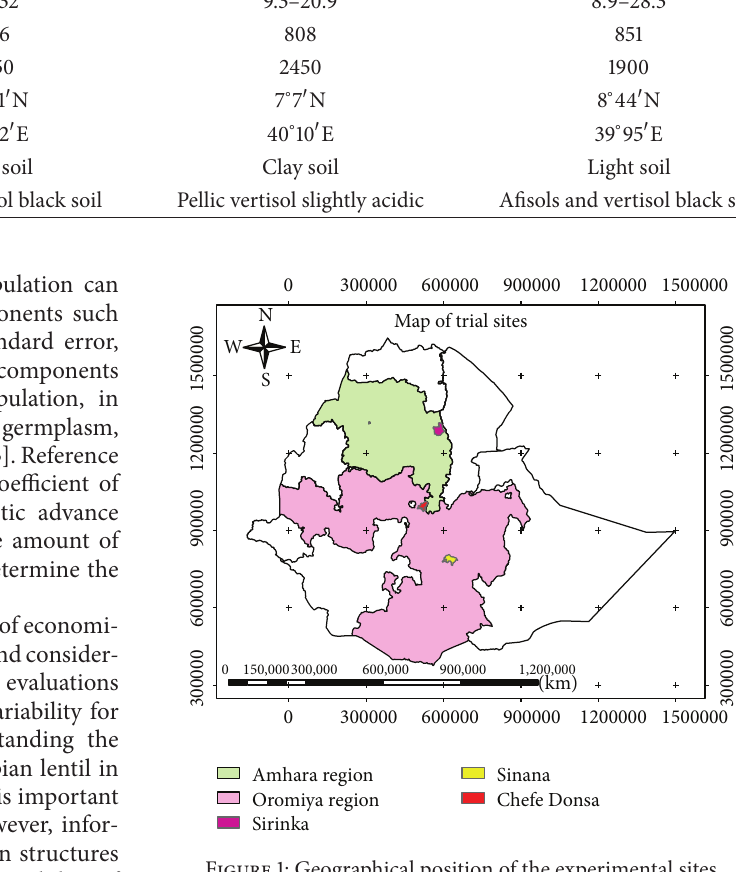
Figure 1: Geographical position of the experimental